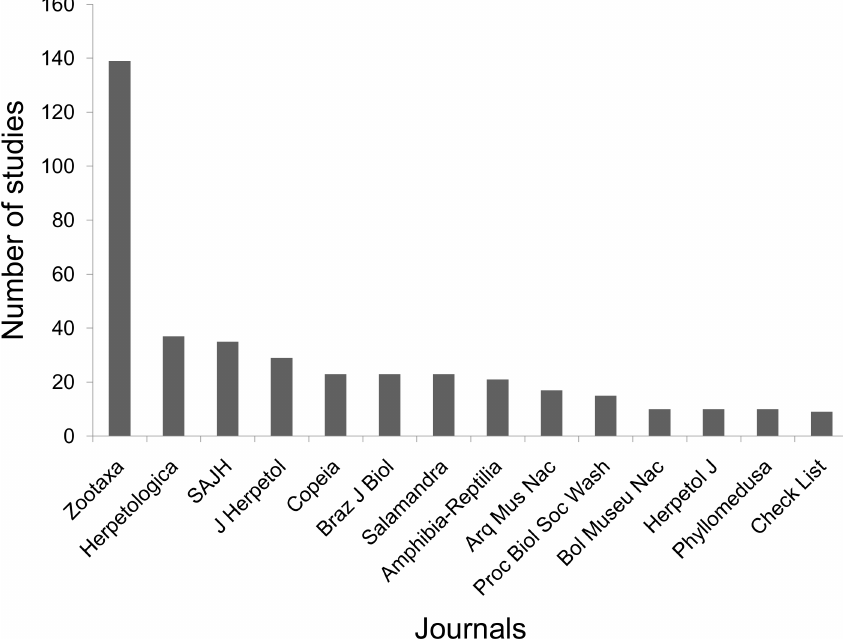
Fig 6. Scientific journals with publications about descriptions of advertisement calls of Brazilian anurans published between 1960 and 2016.